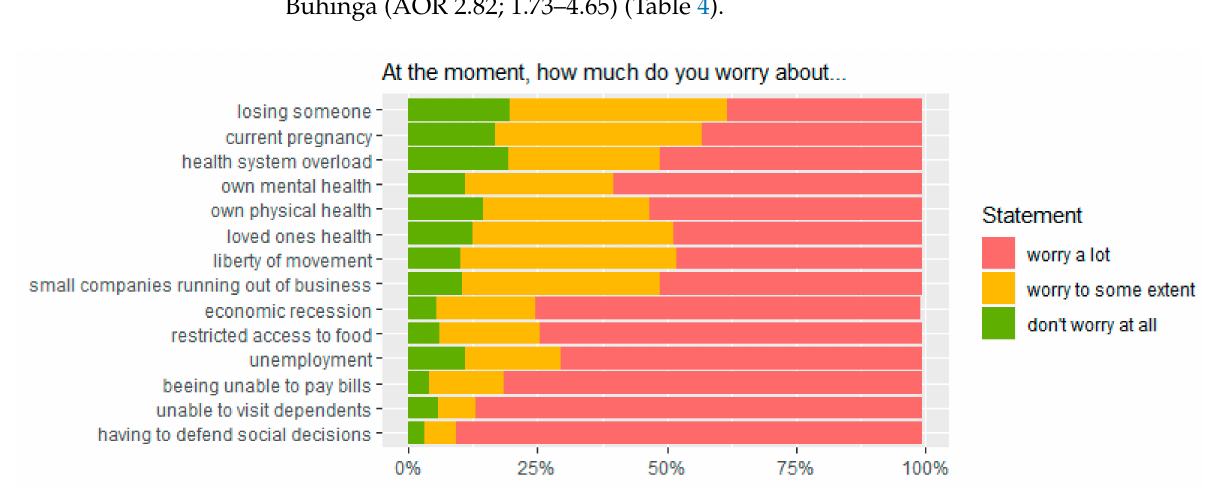
Figure 1. Statements on psycho-emotional stress during the